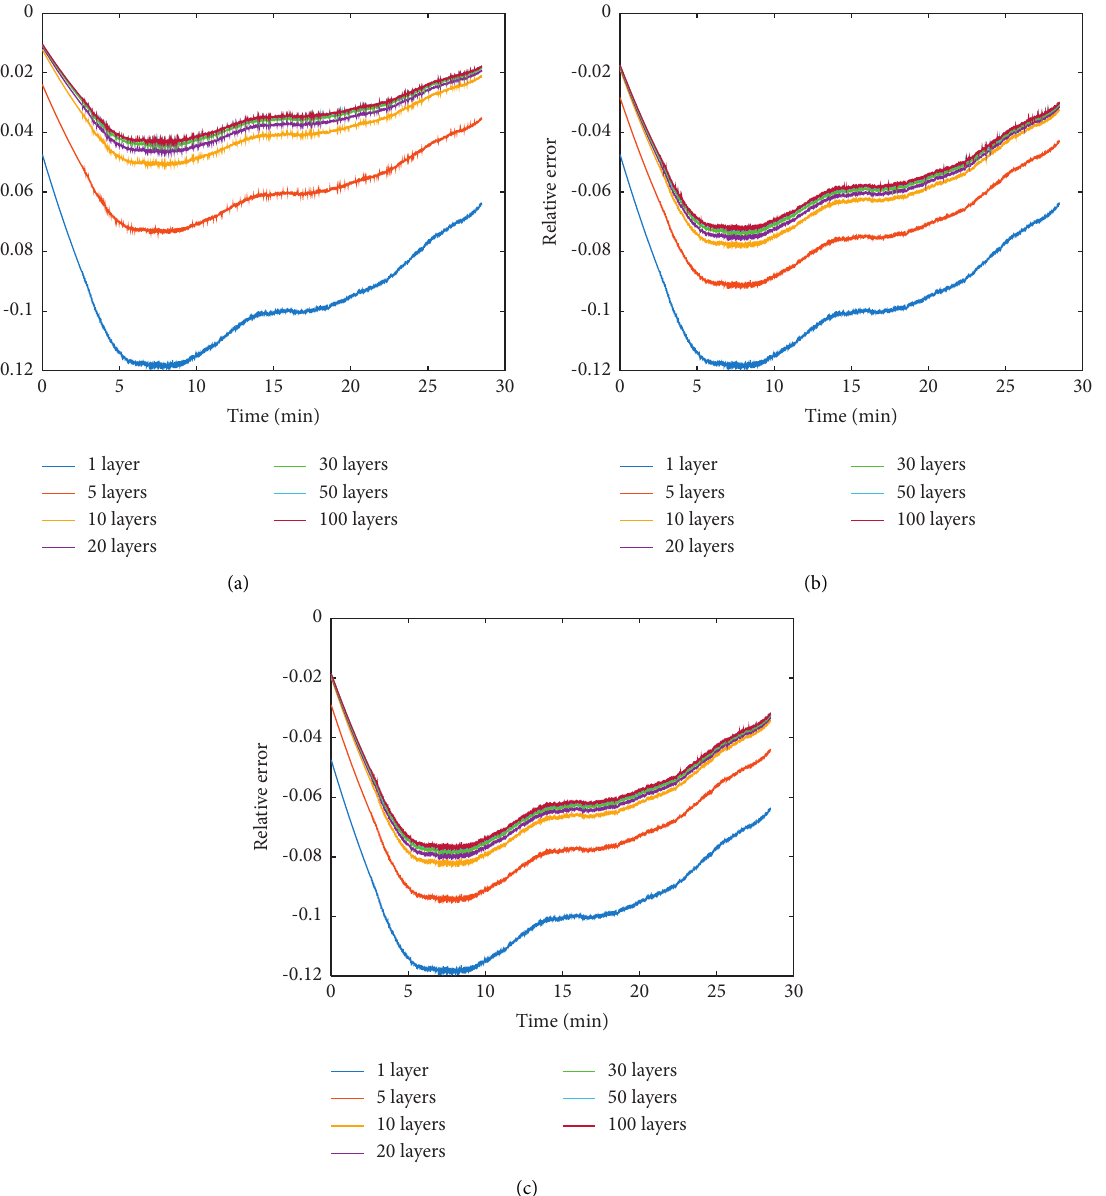
Figure 14: (a) Variation curve of relative error with the number of layers of insulation layer; (b) variation curve of relative error with the number of layers of inner sheath layer; (c) variation curve of relative error with the number of layers of outer sheath